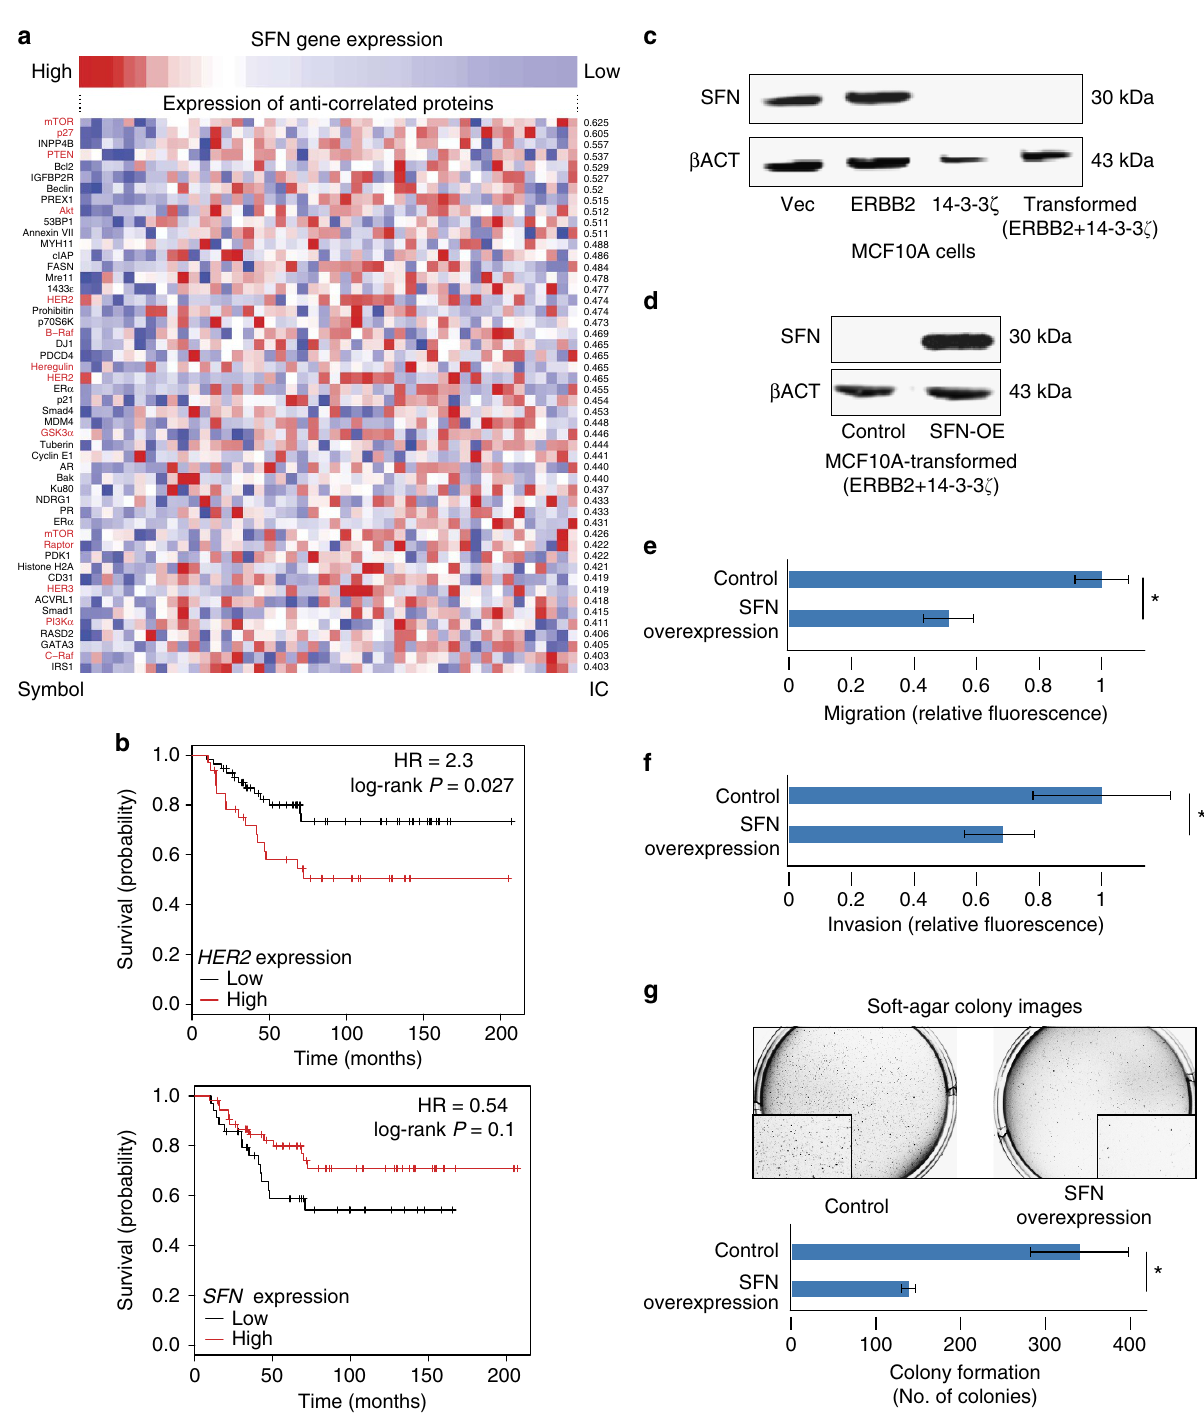
Figure 5 | Downregulation of SFN promotes HER2 -induced human breast cancer tumorigenesis. ( a ) SFN expression level is anti-correlated with the protein expression level of multiple members of the HER2 pathway in human breast cancer cell lines. Presented are the 50 most negatively associated proteins, the HER2 pathway members are labelled in red. IC, information coefficient. ( b ) Low expression of SFN and high expression of HER2 are associated with worse prognosis in HER2 -enriched subtype tumours. Presented are Kaplan–Meier plots of the patients’ overall survival based on a limited cohort of 89 HER2 -enriched subtype patients 46 . ( c ) Immunoblot analysis of SFN protein levels in stable MCF10A cell lines overexpressing an empty vector (MCF10A-Vec; non-tumorigenic), HER2 alone (MCF10A-ERBB2; non-tumorigenic), 14-3-3 z alone (MCF10A-14-3-3 z ; non-tumorigenic) or both (MCF10A-ERBB2/14-3-3 z ; tumorigenic). Expression of 14-3-3 z results in significant reduction of SFN expression. ( d ) Immunoblot analysis of SFN protein levels in transformed MCF10A cell lines. Overexpression of the SFN open reading frame restores SFN protein expression. ( e ) Decreased migration of transformed MCF10A cells following the restoration of SFN expression, as evaluated by a transwell migration assay. * P ¼ 1.5 (cid:3) 10 (cid:2) 5 (Student’s t -test). ( f ) Decreased invasion of transformed MCF10A cells following the restoration of SFN expression, as evaluated by a transwell invasion assay. * P ¼ 0.04 (Student’s t -test). ( g ) Decreased colony formation of transformed MCF10A cells following the restoration of SFN expression, as evaluated by a soft-agar assay. Upper panel: images of colonies. Lower panel: quantification of the number of colonies in each condition. * P ¼ 0.04 (Student’s t -test). Bar plots represent the mean ± s.d. Experiments were performed in triplicates. See also Supplementary Figs